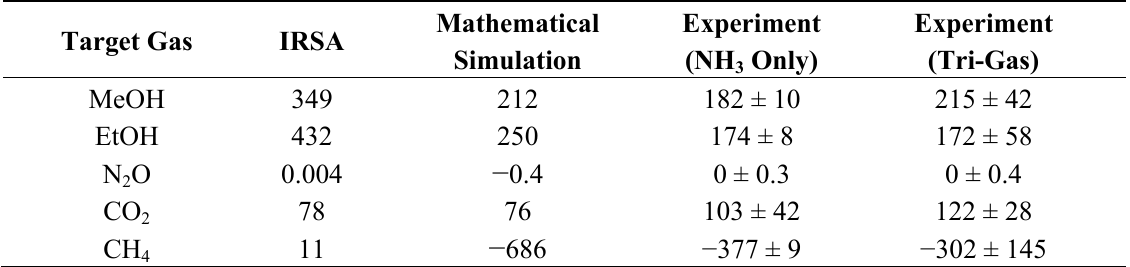
Table 3. Comparison of NH non-target gas (ppb per ppm NH